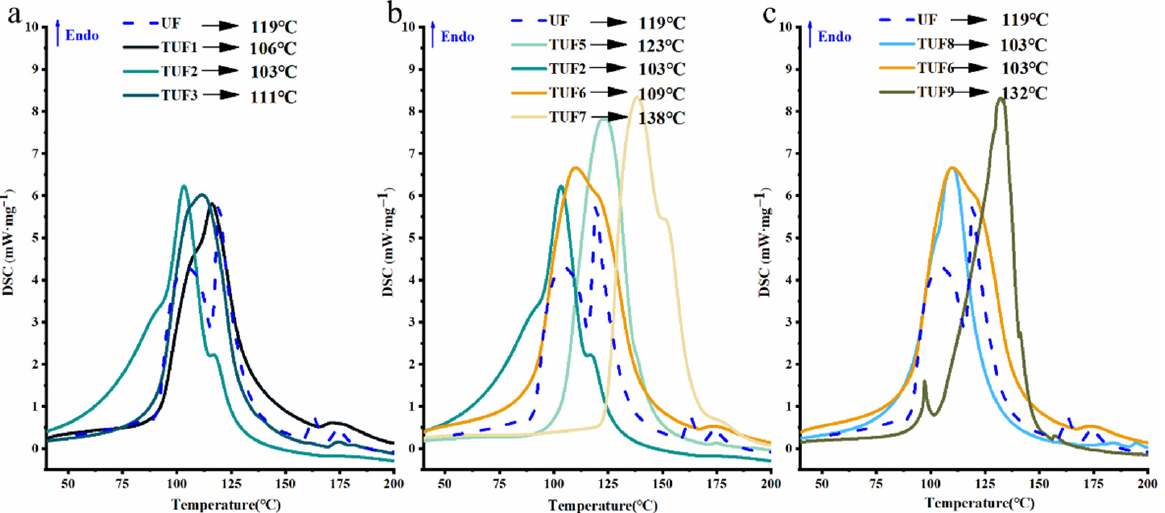
Figure 4. DSC of UF and TUF resins prepared under varied reaction conditions. ( a ) reaction temperature; ( b ) reaction time; ( c ) tannin addition.